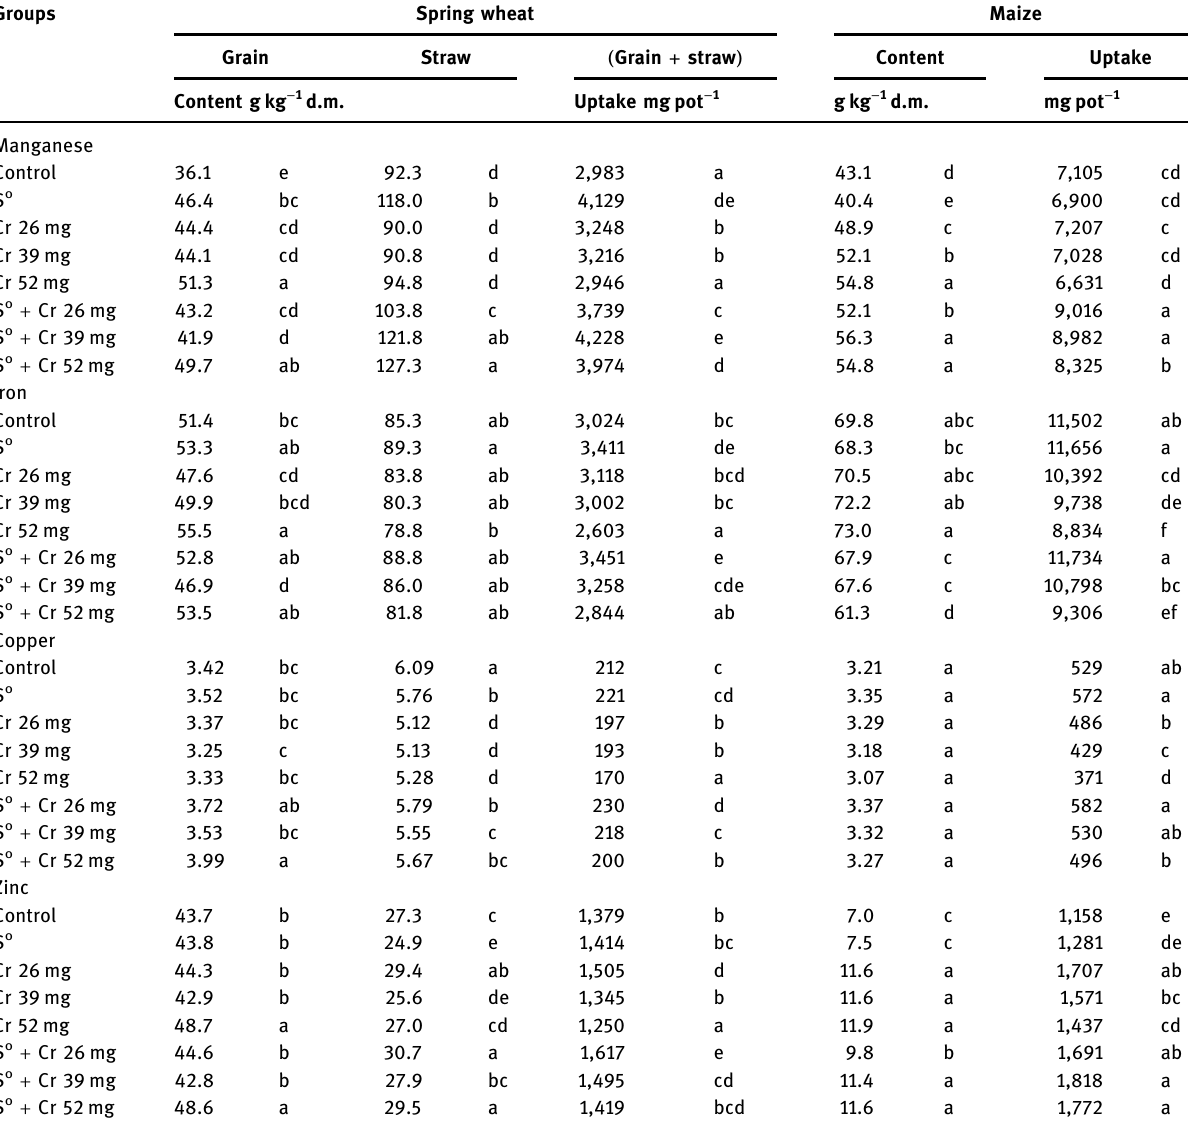
Table 6: Microelements ( Mn, Fe, Cu, and Zn ) content and uptake in cultivated plants Groups Spring wheat